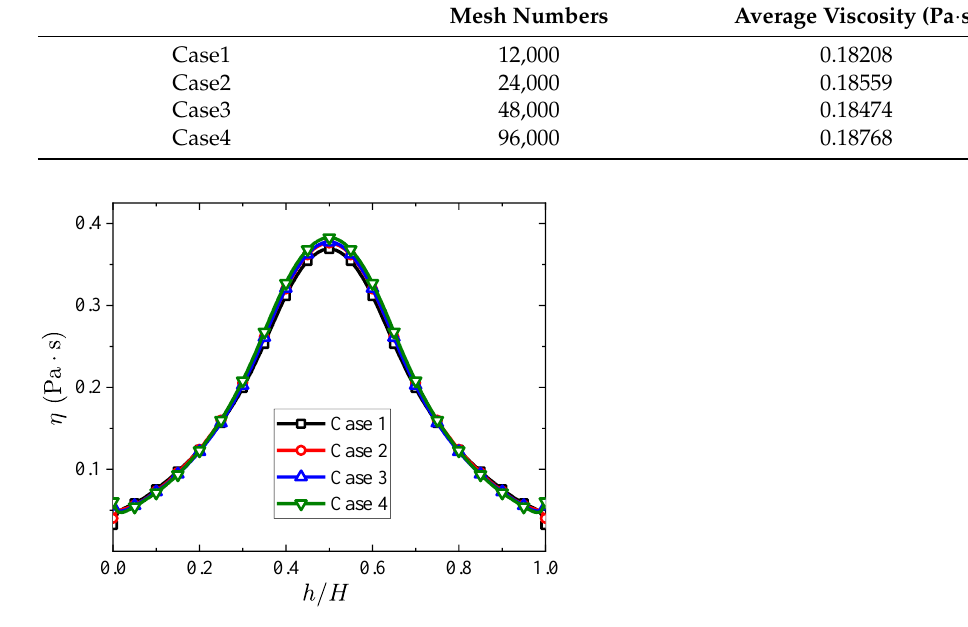
Figure 3. Average viscosity distribution at the outlet for different mesh numbers.